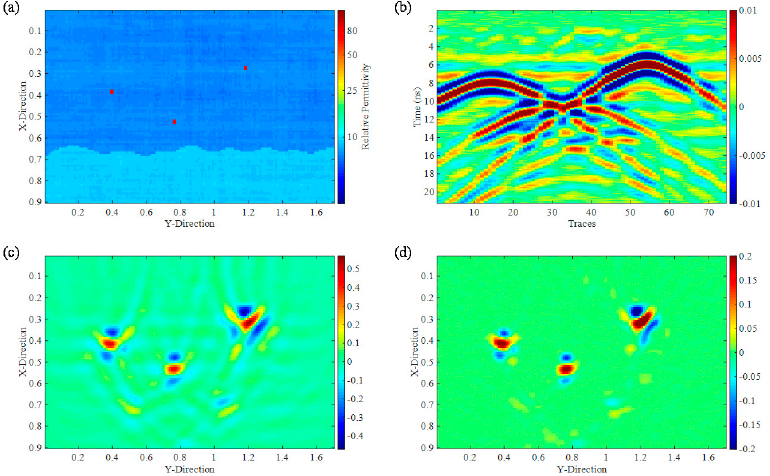
Figure 4. The water- bearing seepage channel model. ( a ) the distribution of relative permittivity; ( b ) 2-D GPR profile; ( c ) back projection imaging; ( d ) RPCA anomaly extraction. ( b ) 2-D GPR profile; ( c ) back projection imaging; ( d ) RPCA anomaly